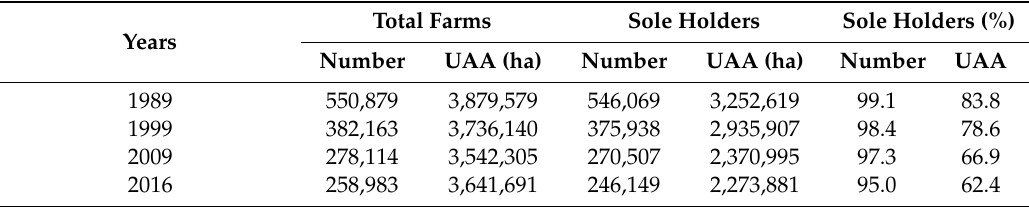
Table 1. Number of farms and utilised agricultural area (UAA) in Portugal. Total Farms Sole Holders Sole Holders Years